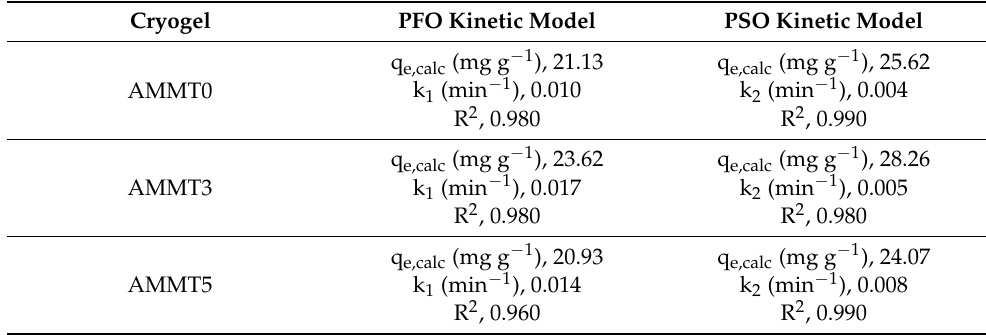
Table 2. PFO and PSO kinetic parameters for MB adsorption onto AMMT0, AMMT3, and AMMT5 samples at the initial dye concentration of 25 mg L − 1